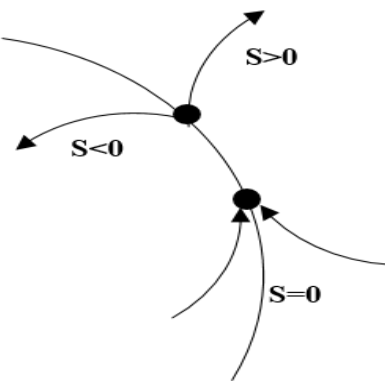
Figure 5. Switching surface characteristics.